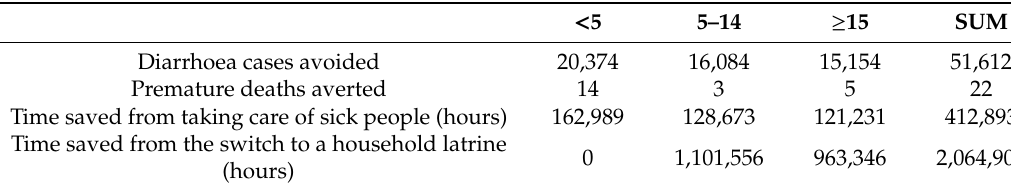
Table 2. Health and time benefits from the CLTS